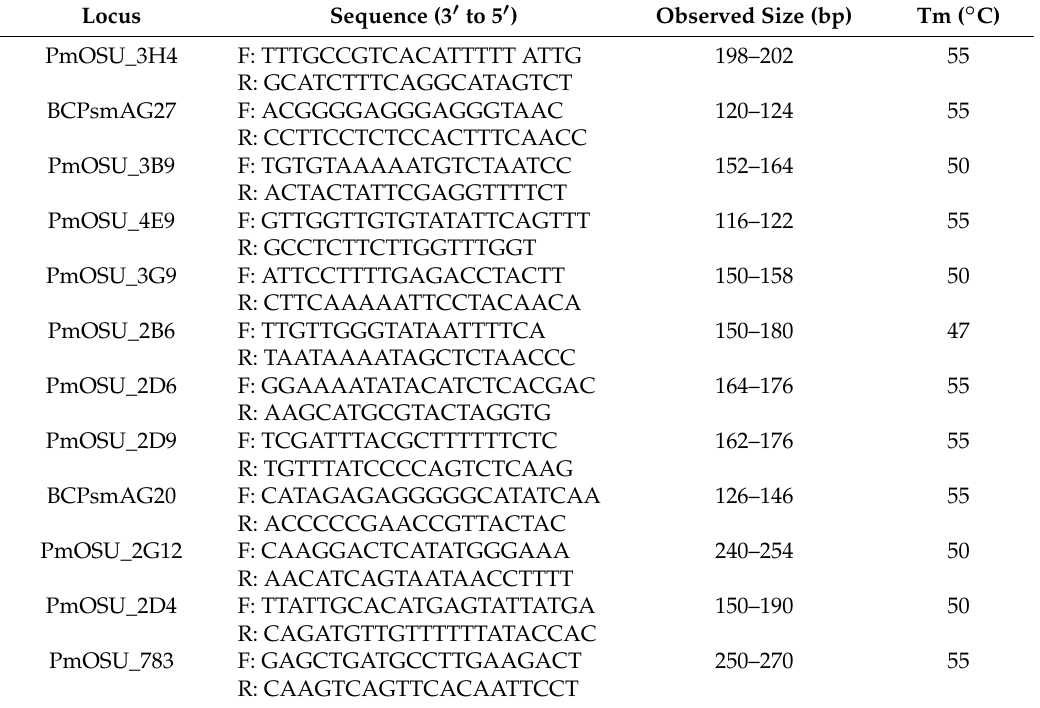
Table 2. Characteristics of 12 pairs of microsatellite markers used for the analysis of genetic diversity and structure of 12 Pseudotsuga menziesii (Mirb.) Franco